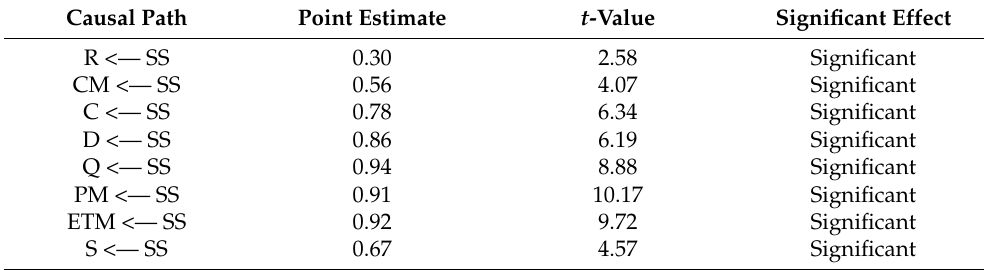
Table 3. The effects of supplier selection and evaluation criteria on SS process. Causal Path